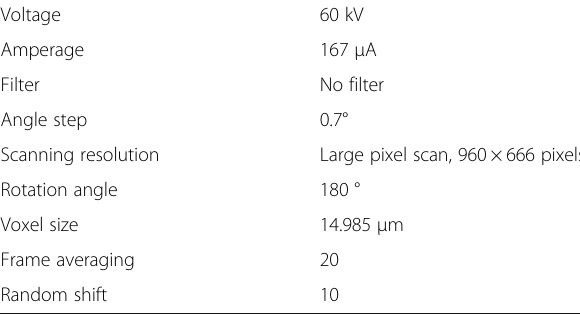
Table 1 Micro-CT scanning parameters of the replicas before and after